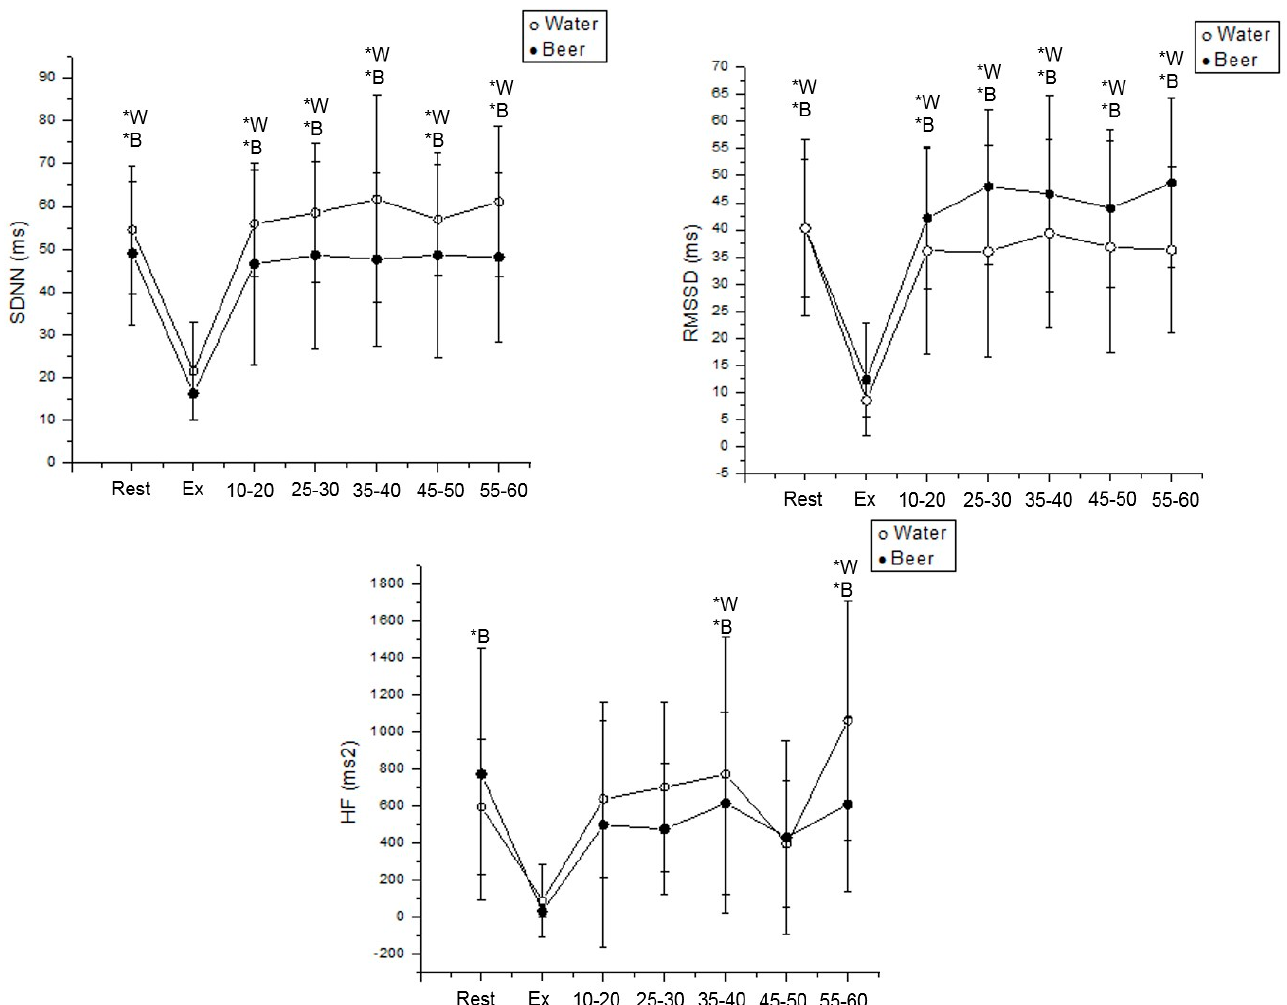
Figure 6. SDNN, RMSSD and HF values were obtained at rest, during exercise and during recovery from moderate aerobic exercise protocol in women. *W: Values with significant differences in relation to exercise ( p < 0.01) for water protocol; *B: Values with significant differences in relation to exercise ( p < 0.01) for beer protocol.